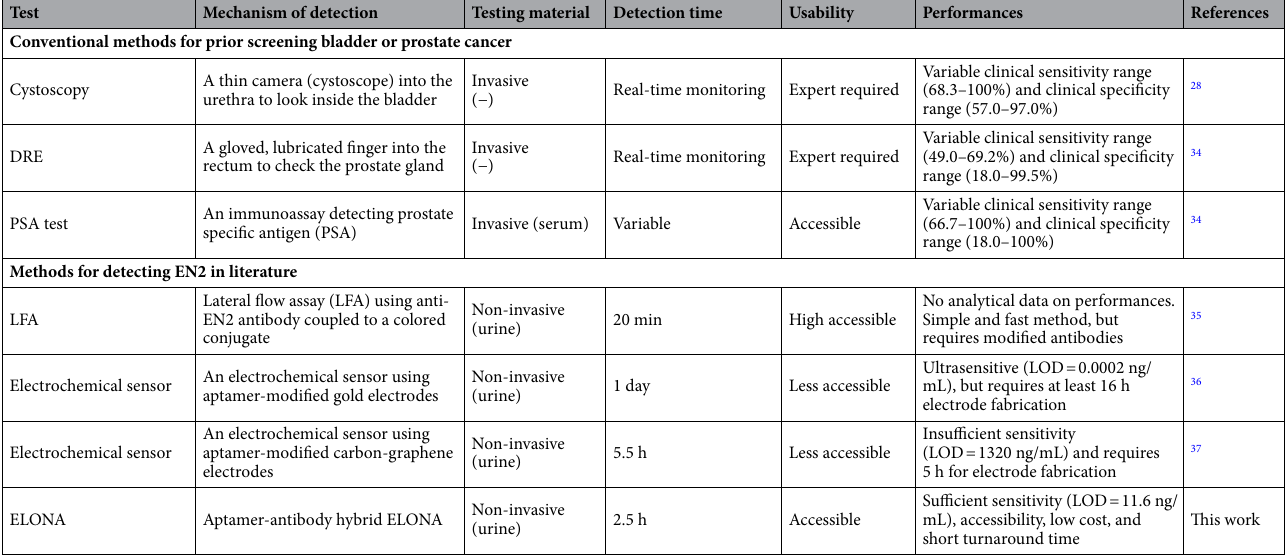
Table 1. Comparison of the proposed ELONA with conventional bladder or prostate cancer diagnostics and other EN2 detection